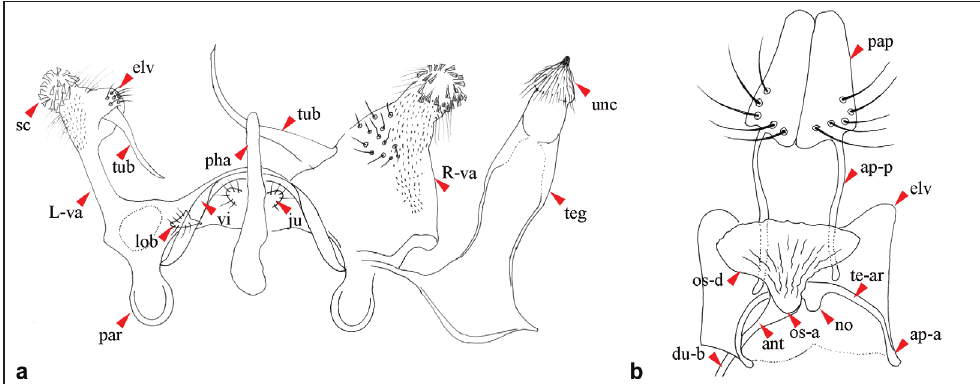
Figure 4. Anarsia genitalia (schematic). a. male, elv : elevation at left valva (sub-apical lobe); ju: juxta; L-va: left valva; lob: lobe at left side of vinculum; par: parategminal sclerite; pha: phallus; R-va: right valva; sc: